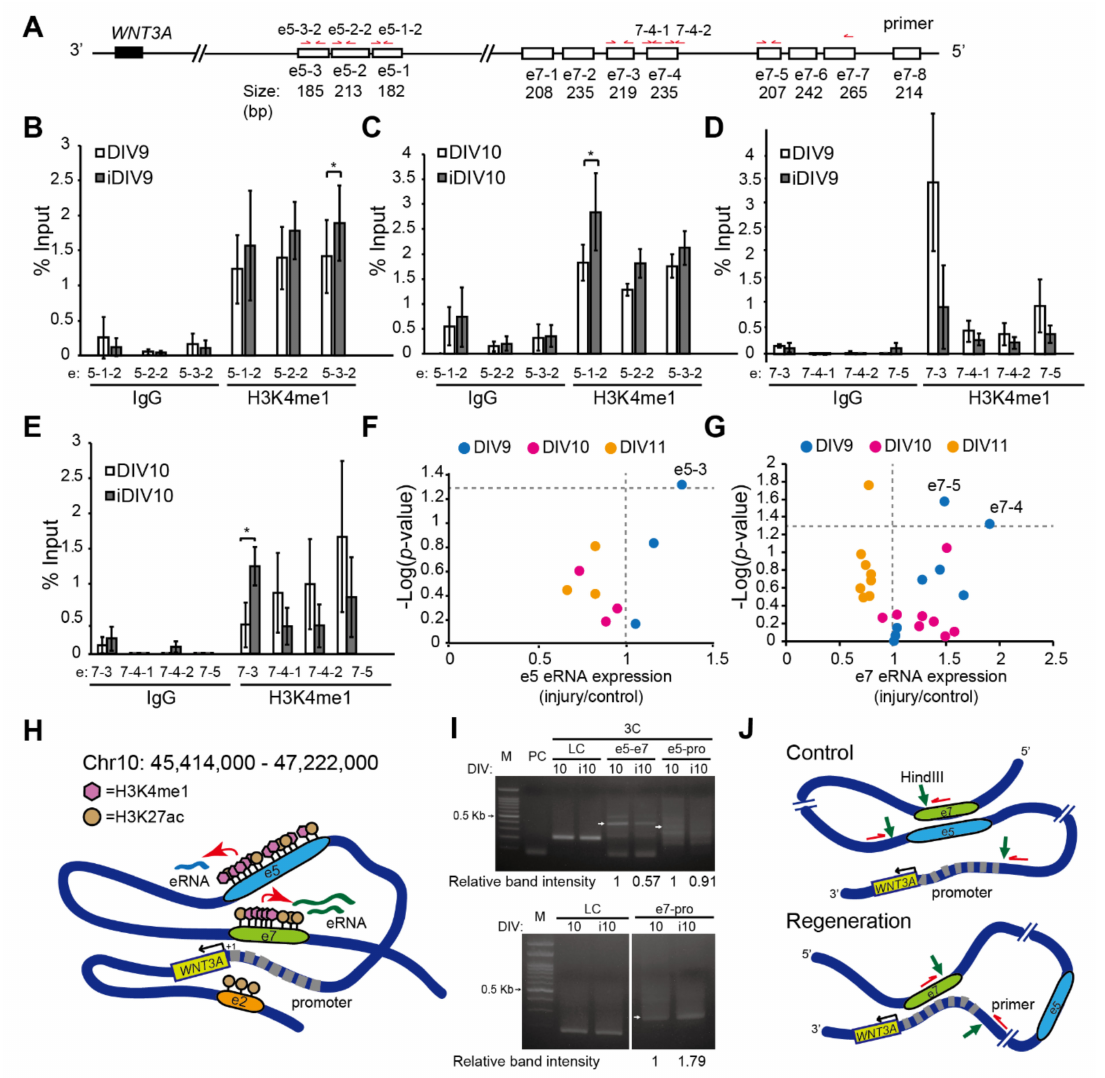
Figure 5. H3K4me1 modifications, enhancer RNAs (eRNAs) and topological transformation at WNT3A enhancer / promoter regions during neuronal regeneration. (A) Schematic diagram of primers design for ChIP-qPCR assays at e5 and e7 regions. ( B–E ) ChIP-qPCR was performed to examine the relative H3K4me1 modifications at the e5 ( B,C ) and e7 ( D,E ) regions. IgG enrichment was used as a negative control. Samples were from cortical neurons on DIV9, iDIV9, DIV10 and iDIV10, respectively. Data are mean ± SEM ( n = 3 and n = 4 for experiments on DIV9 and DIV10, respectively). * P ≤ 0.05 (two-way ANOVA followed by Tukey’s test, comparing the enrichment of IgG or H3K4me1 between control and injured samples at the indicated time points). ( F,G ) Volcano plots displaying di ff erential expression (DE) of e5 and e7 eRNAs between control and injured samples on DIV9, DIV10 and DIV11. The x-axis represents the fold change of eRNA expression, which was calculated based on the results of RT-PCR. The y-axis corresponds to –log ( P -value), determined by paired Student’s t -test, comparing e5 or e7 eRNA expressions between control and injured sample at the indicated time points. Vertical gray dotted line represents the value of DE = 1, while the horizontal gray dotted line borders the cut-o ff value of –log ( P = 0.05). eRNA DE values are shown as mean from at least three independent experiments (e5: n = 3; e7: n = 4). ( H ) Schematic summary of histone H3K4me1- and eRNA-mediated enhancer regulation for WNT3A transcription during regeneration. Dark blue line depicts genomic DNA ranging from predicted enhancers e1 to e10. Relative position of the e2, e5, e7 enhancer regions are